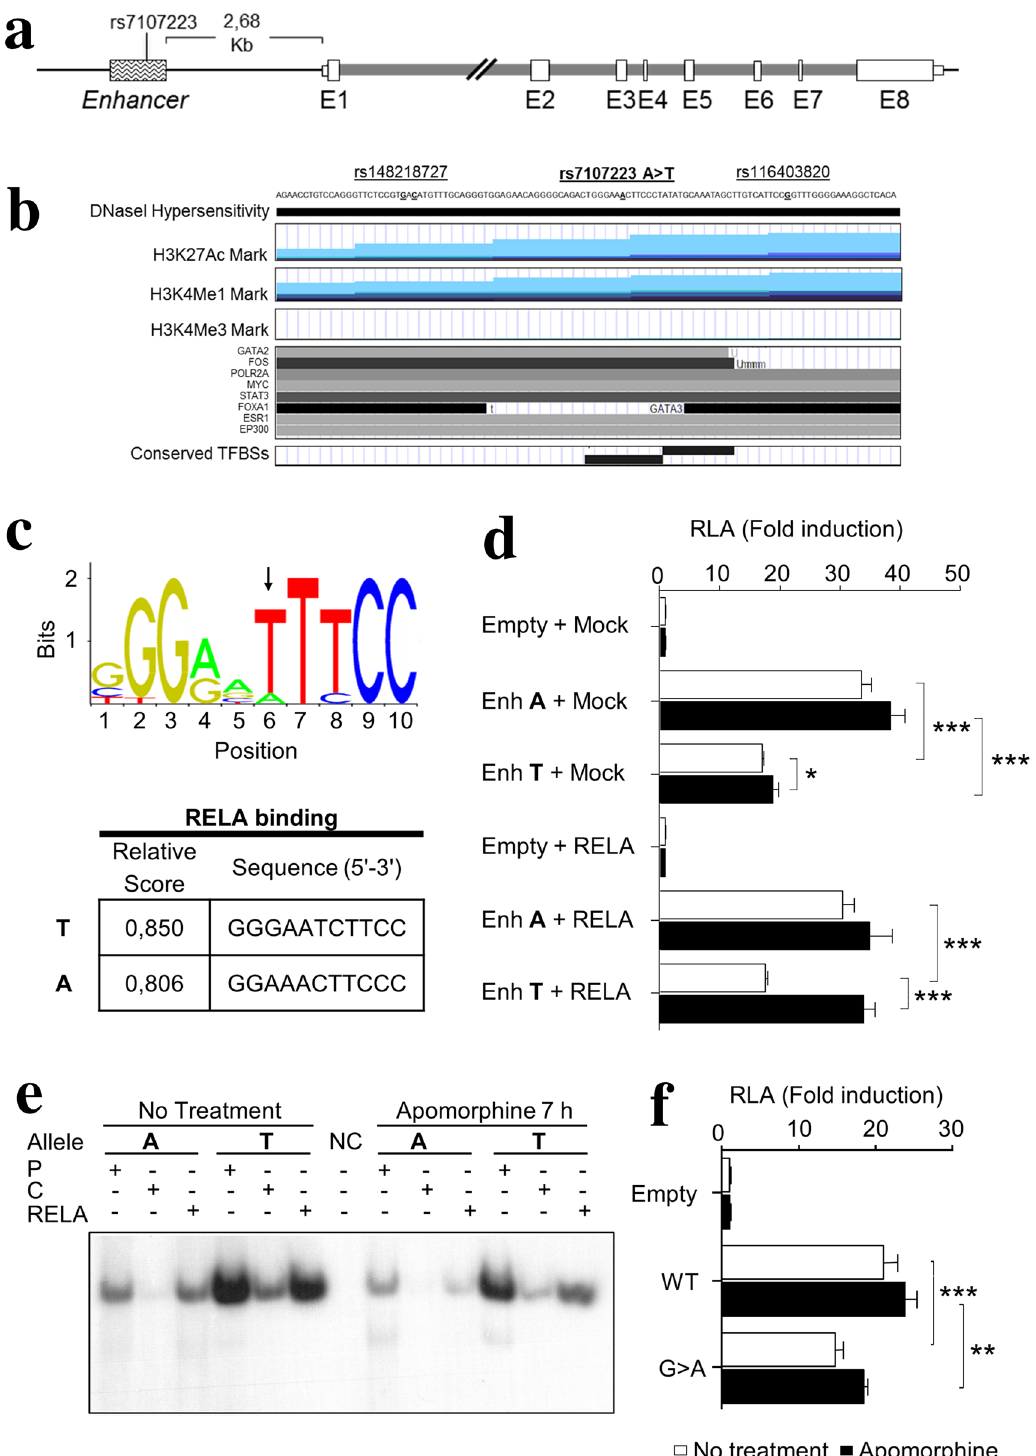
Figure 3. ANKK1 enhancer activity is affected by rs7107223 alleles. ( a ) ANKK1 locus showing both an enhancer located 2.68 Kb upstream (wave pattern-block) and coding exons (white blocks). ( b ) ENCODE chromatin modifications marks of ANKK1 enhancer in HUVEC (blue), NHEK (violet), and HSMM (green) cell lines. Histone acetylation and methylation marks for H3K27Ac, H3K4m3, and H3K4m1 indicate an enhancer. DNaseI hypersensitivity indicates regulatory regions and TFBSs ( c ) Human binding motif of RELA and relative scores and sequence for RELA BS in the rs7107223 region. Data obtained from JASPAR database. ( d ) RLA of rs7107223 alleles constructs or after co-transfection with T7-RelA plasmid. ( e ) EMSA of rs7107223 alleles using radiolabeled probes (P), molar fold excess of non-labeled competitors (C) as a control and RELA as a competitor. ( f ) RLA of g.113384813G>A alleles constructs. HEK293T cells untreated and treated with apomorphine were used in D, E and F. Data are shown as mean ± SEM (N = 4). Asterisks indicated statistical significance (* P < 0.05, ** P < 0.01, *** P < 0.001), one-way ANOVA followed by Tukey correction was